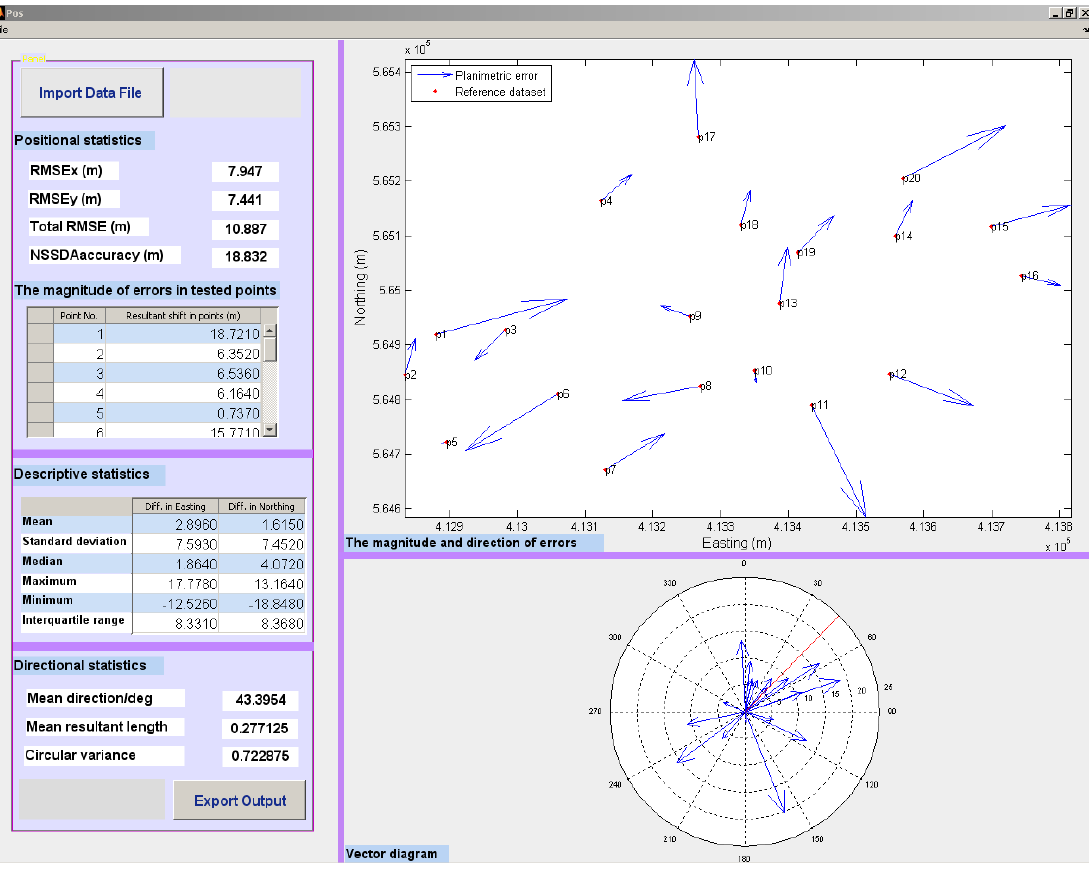
Figure 9. The positional similarity measurement results for the comparison of OS-OSM datasets in Clara Vale-UK.